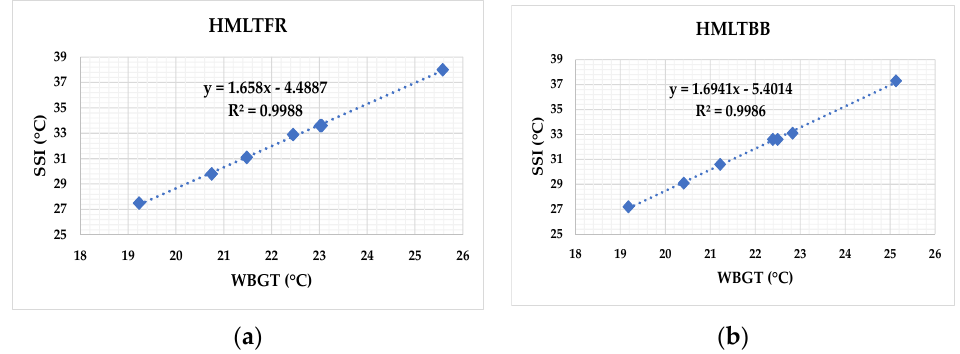
temperatures ranged from 24.2 ◦ C to 25.6 ◦ C within the case studies. The correlations showed that lower neutral temperatures for WBGT than those values computed for SSI in the buildings.